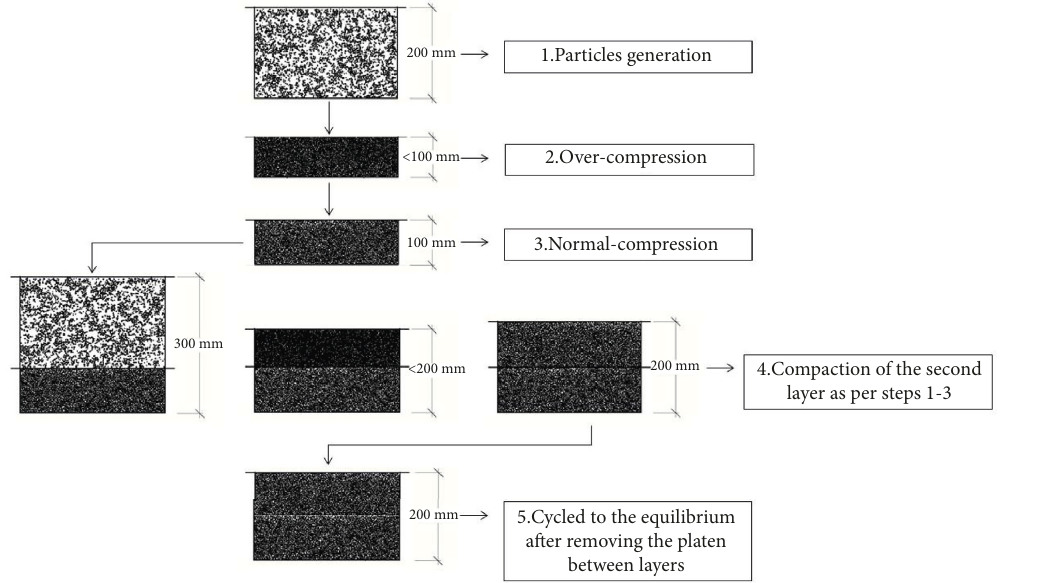
Figure 4: Flowchart of an improved multilayer compaction method.